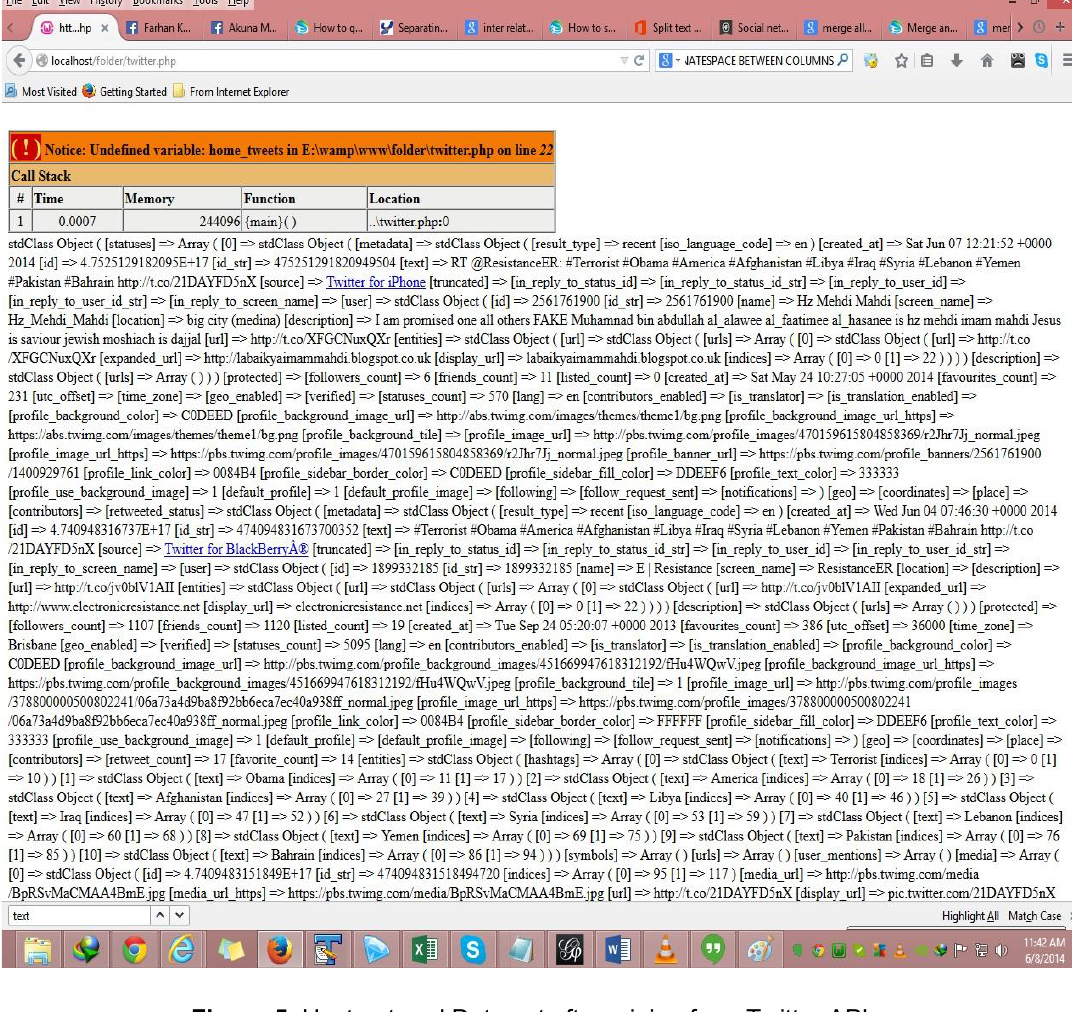
Figure 5. Unstructured Data set after mining from Twitter API